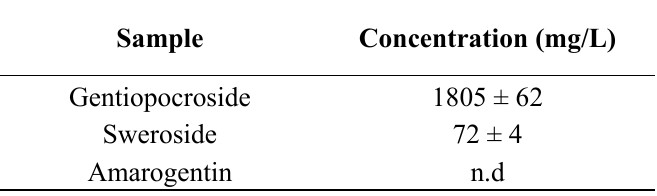
Table 2. Amount of secoiridoid-glycoside quantified by